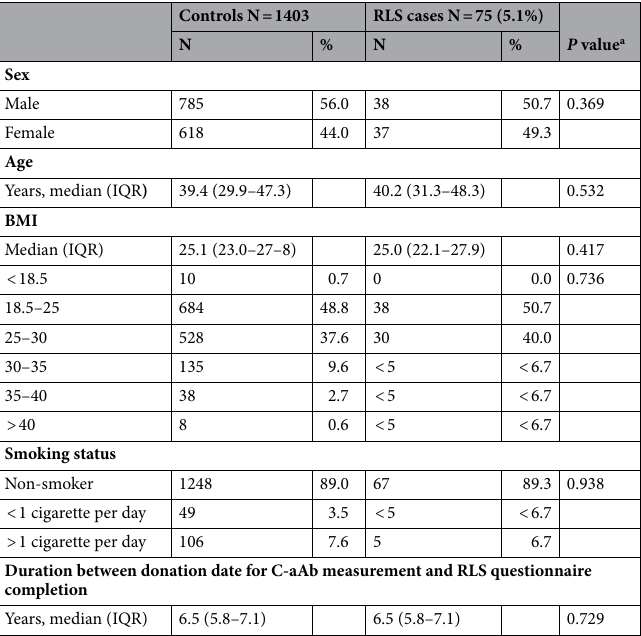
Table 3. Demographic descriptive statistics of RLS cases and controls in the DBDS cohort with available c-aAb data and RLS data (N = 1478). C-aAb cytokine-specific autoantibody, IQR interquartile range. a For comparison of the two groups, chi-square test was used for categorical variables and Kruskal–Wallis rank test was used for continuous variables.